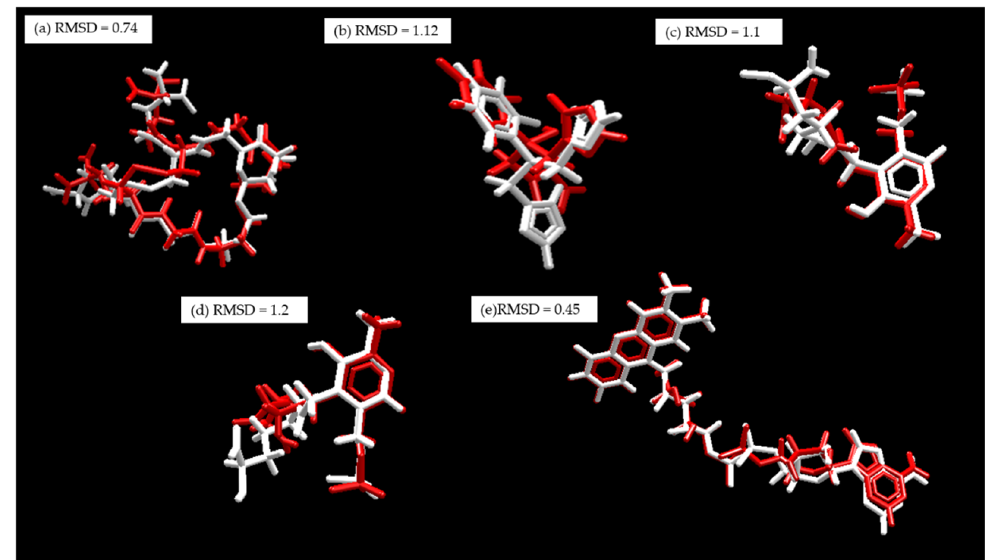
Figure 15. Re-coupling, white: co-crystallized substrate. Red: Substrate coupled using MVD. ( a ) Tc TR; ( b ) Tc L α D, ( c ) Li TA, ( d ) La A, and ( e ) L